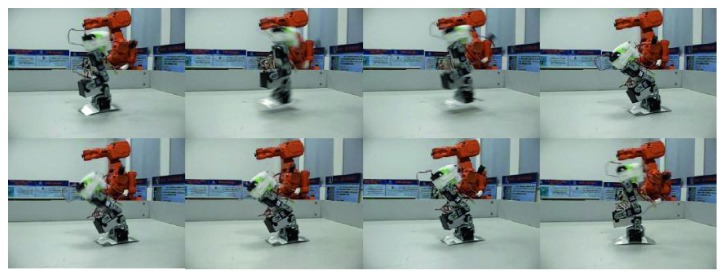
Stable jump process [94].